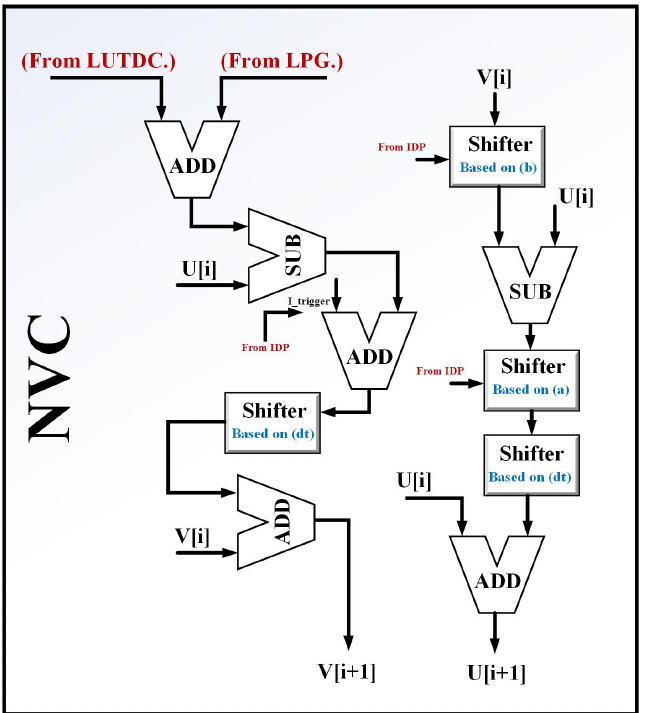
Figure 6. Proposed scheduling diagram for calculating the output neuron voltage.